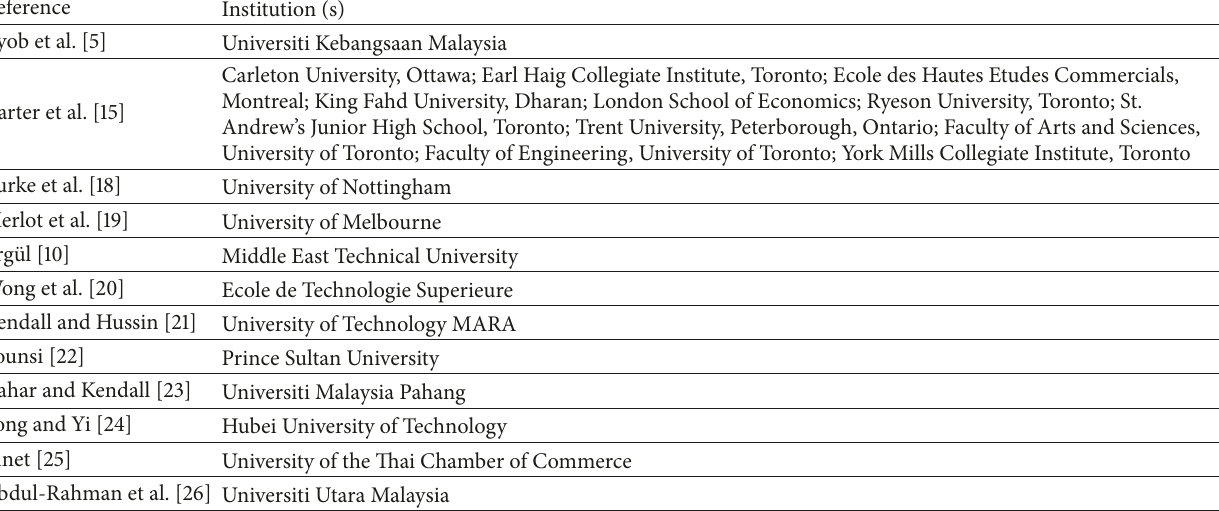
Table 2: Summary of real-world examination timetabling datasets from different